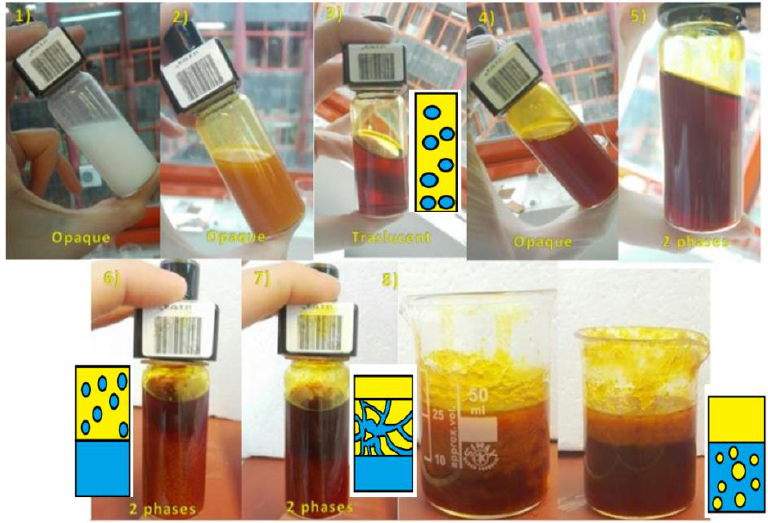
Figure 7. Evolution of the microemulsion system CTAB-1butanol-1hexanol with the increasing water phase content. A schematic view of the vial is showed for better understanding of the phases formed while the aqueous phase was added during